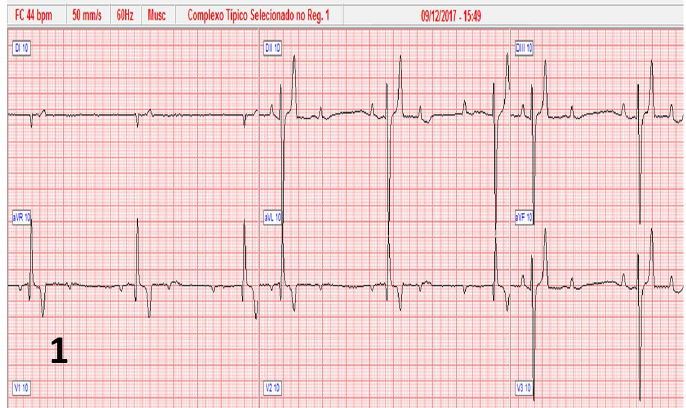
Figure 1. The ECG shows 3AVB, with monomorphic ventricular escape beats of RBB type, with rate of 43/min. Atrial and ventricular activities are dissociated each other. The atrial repolarization is noticeable. The bizarre and wide QRS with RBB pattern indicates that the rescue pacemaker is in the left ventricle. Paper speed = 50 mm/sec; calibration: 1 cm =